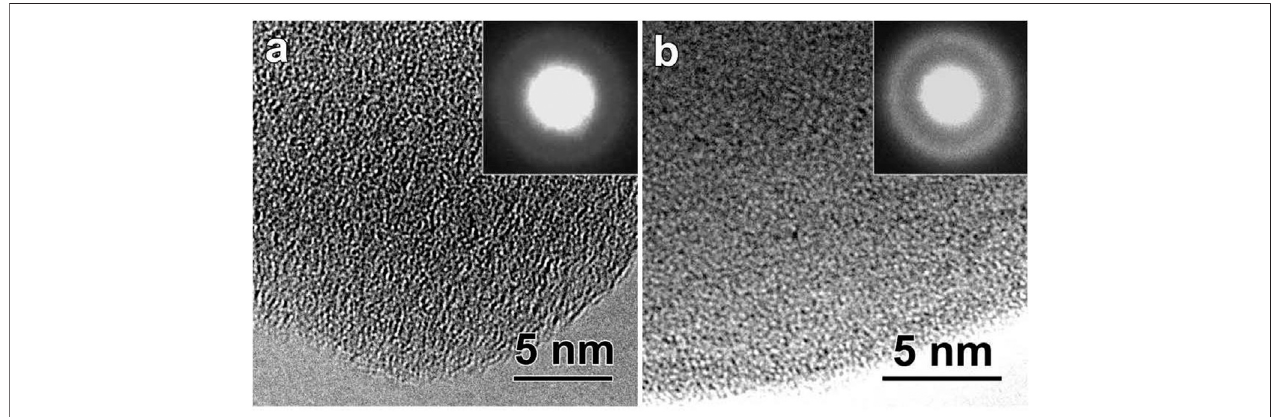
FIGURE17|(A) HRTEMimageoftheatomicstructurefortheas-depositedAu 52 Ag 5 Pd 2 Cu 25 Si 10 Al 6 nanoglass. (B) HRTEMimageoftheatomicstructureformelt- spun ribbon. For both the nanoglass and ribbon sample, the amorphous atomic structure can be con fi rmed by the inserted diffraction patterns (from (Wang J. Q. et al., 2014)).